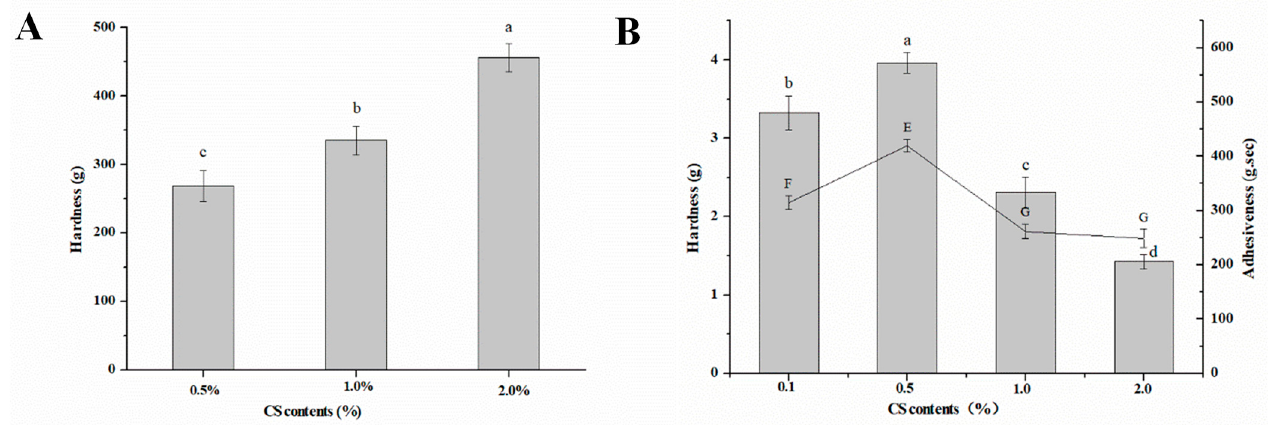
Figure 4. Texture properties of freeze-dried products ( A ) and oleogels ( B ) from COBET with different CS content, where the histogram (left) refers to hardness, and the line graph (right) refers to adhesiveness. Different letters (a–d) indicate significant differences ( p < 0.05) in hardness while letters (E–G) indicate significant differences ( p < 0.05) in Adhesiveness.